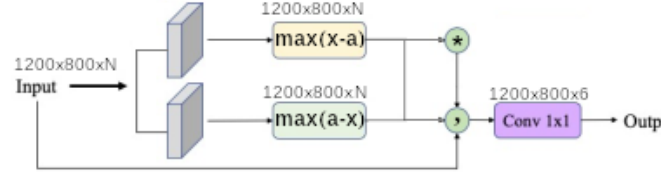
Figure 8. Input Band Filter inserted at the beginning of the